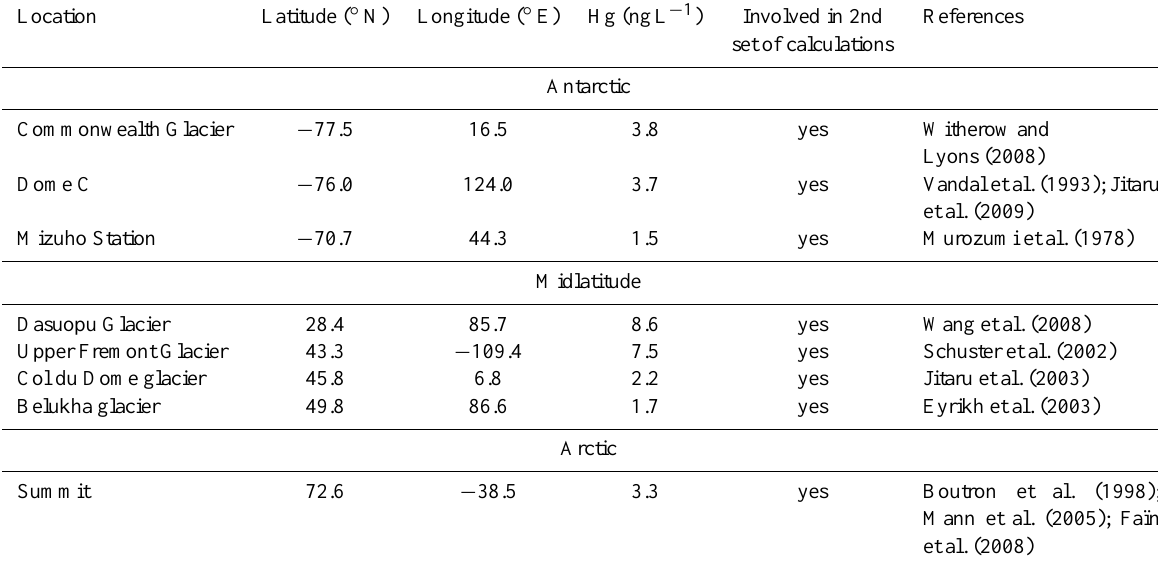
Table 5. Mean concentrations of total mercury in long-term snowpack-related records.